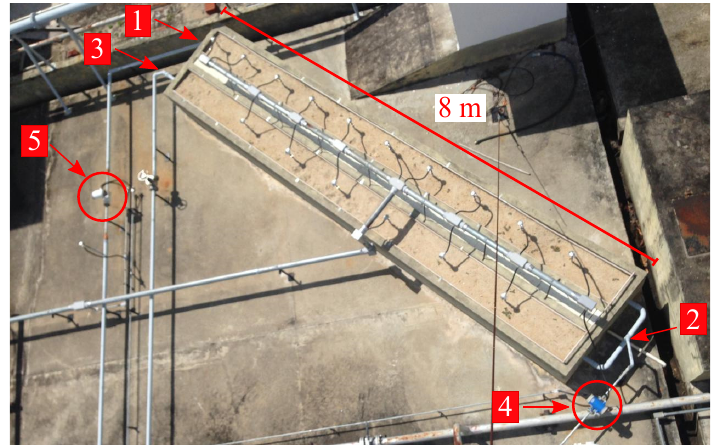
Figure 3. Top view of the prototype well once built. 1 —well-head; 2 —injection zone 1; 3 —injection zone 2; 4 —flow sensor; 5 —flow